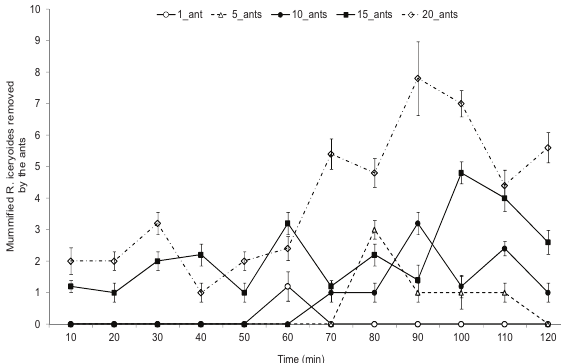
Figure 2. Mean number (±standard error) of mummified Rastrococcus iceryoides removed and transported by the different Oecophylla longinoda ant groups (treatments) from the foraging cages at 10 min intervals over a 2 h observation period.